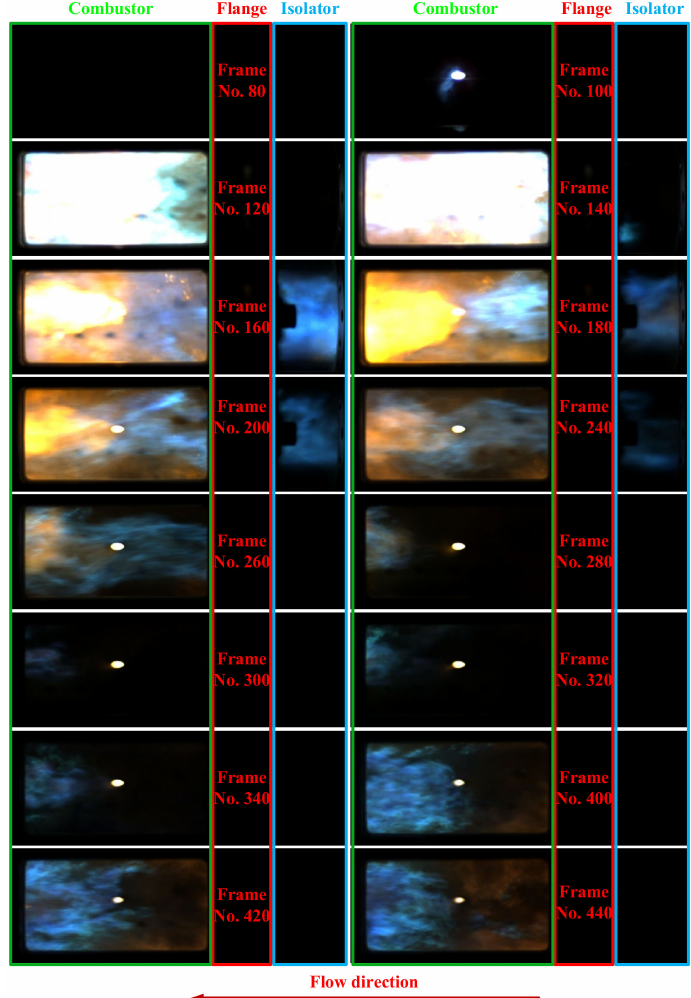
Figure 6. High-speed images of the ignition process of Case #1. (Original images).